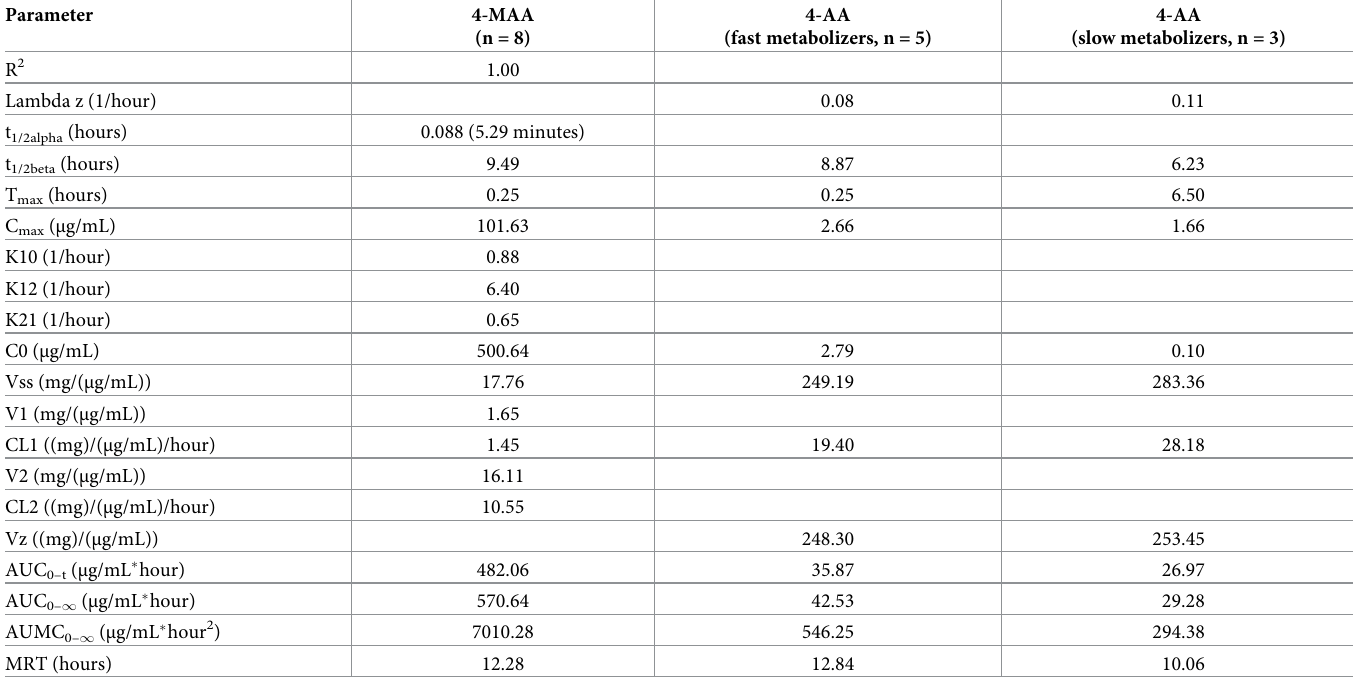
R 2 , correlation coefficient; Lambda z, terminal phase rate constant; t 1/2alpha , distribution half-life; t 1/2beta , terminal elimination half-life; T max , time of peak; C max , peak plasma concentration; K10, rate at which the drug leaves the system from the central compartment (elimination rate); K12, rate at which the drug passes from central to peripheral compartment; K21, rate at which the drug passes from peripheral to central compartment; C0, serum concentration at time 0; Vss, volume of distribution at steady-state; V1, volume of distribution in the central compartment; CL1, clearance of the central compartment; V2, volume of distribution in the peripheral compartment; CL2, clearance of the peripheral compartment; Vz, volume of distribution based on the terminal phase; AUC 0–t , area under the plasma concentration– time curve; AUC 0– 1 , area under the plasma concentration–time curve extrapolated to infinity; AUMC 0– 1 , area under the first moment curve from zero to infinity; MRT, mean residence